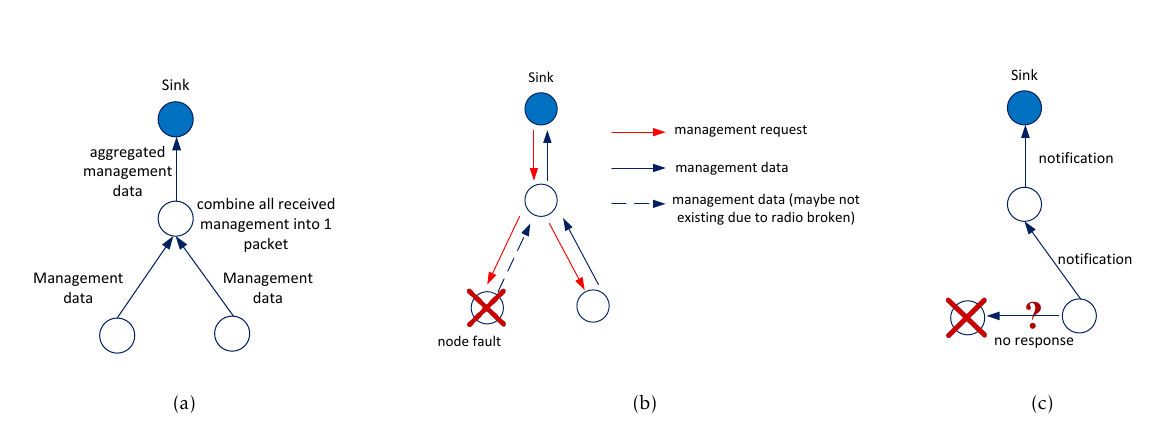
Figure 2. Monitoring mechanisms: (a) Periodic, (b) On demand, (c) Event based monitoring